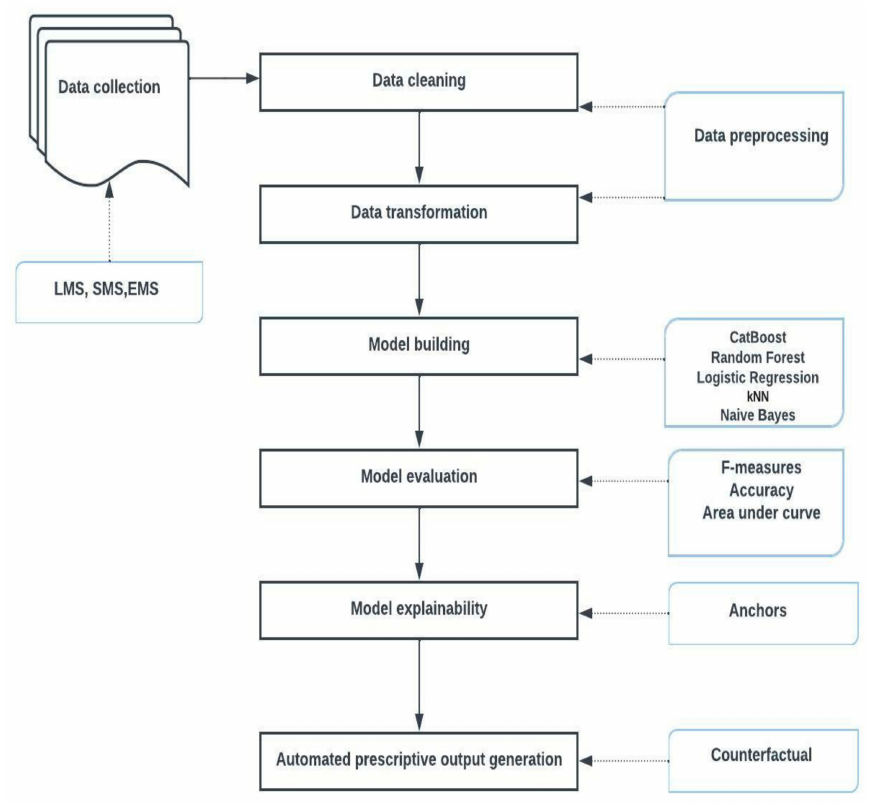
Figure 1. Analytics workflow followed in this